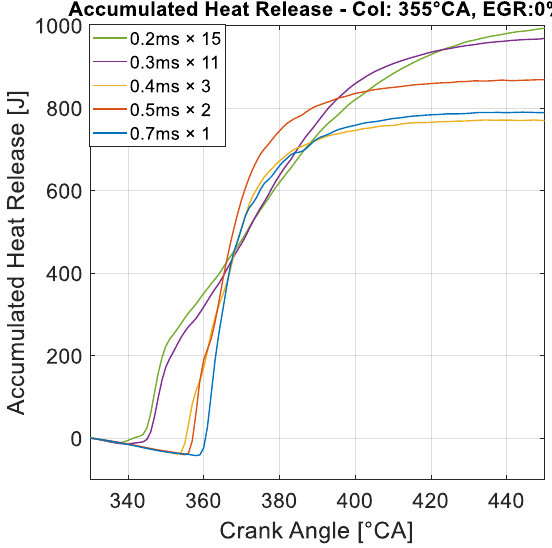
Figure 12. The accumulated heat release of the investigated structures with the same dose in the function of crank angle without EGR. The CoI is 355 °CA in each case.